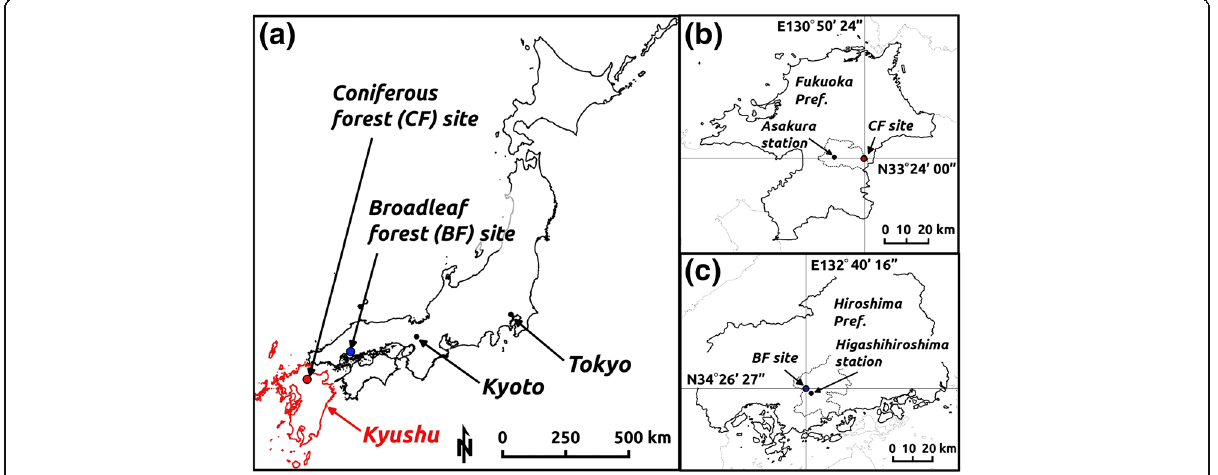
Fig. 1 Study site: a overview, b locations of the coniferous forest (CF) site and the rain-gauge station (Asakura station), and c locations of the broadleaf forest (BF) site and the rain-gauge station (Higashihiroshima